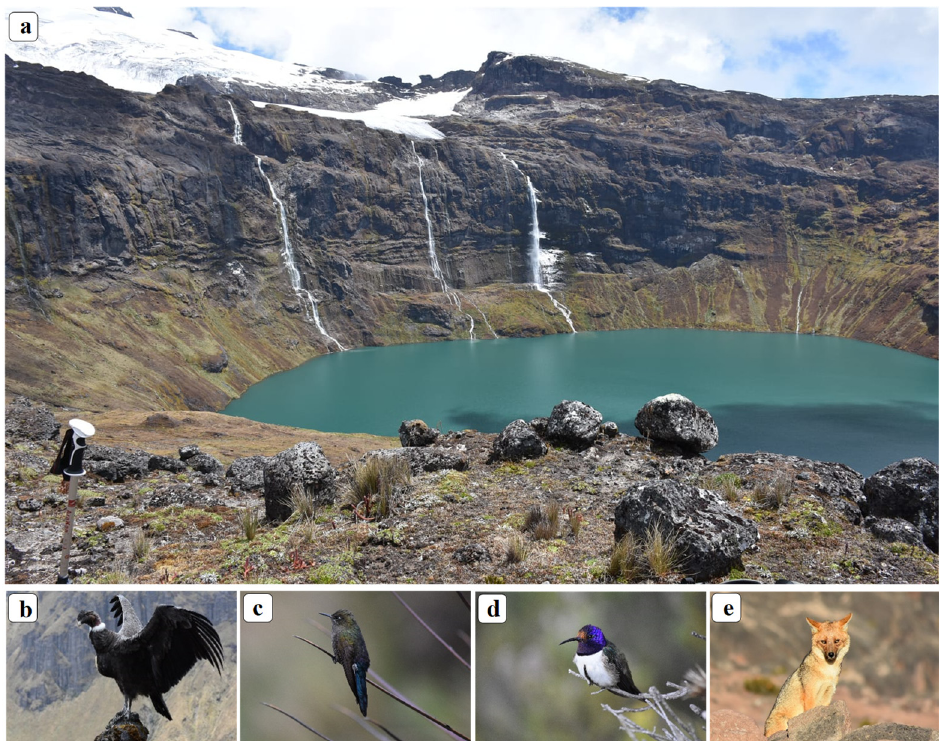
Figure 7. ( a ) Blue lake, ( b ) Vultur gryphus (male), ( c ) Chalcostigma stanleyi (female), ( d ) Oreotrochilus chimborazo (male), and ( e ) Lycalopex culpaeus .